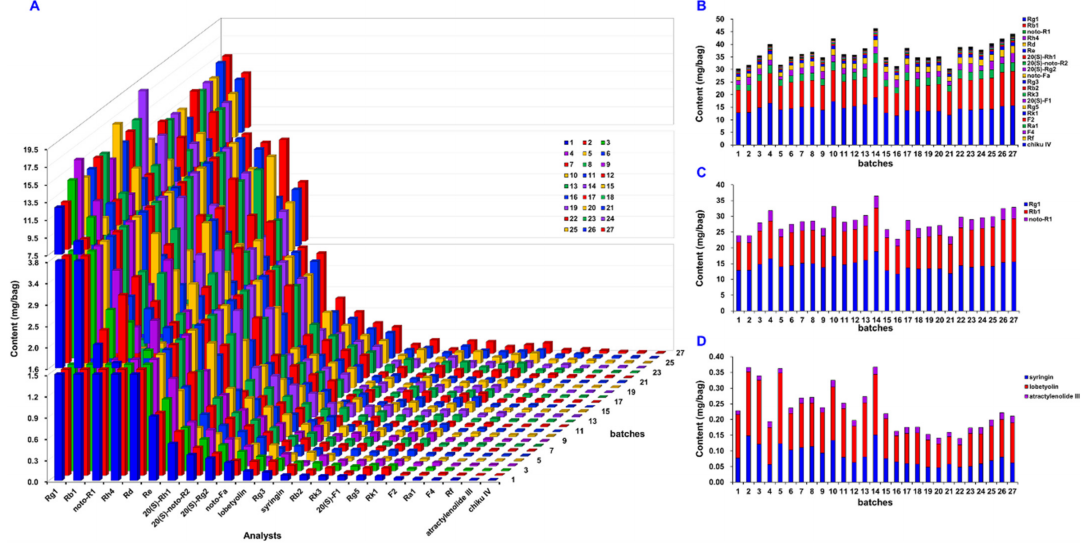
Figure 9. Content determination histograms of 24 compounds in 27 batches of commercial WXG samples: ( A ) the contents of all 24 compounds; ( B ) the contents of ginsenosides; ( C ) the contents